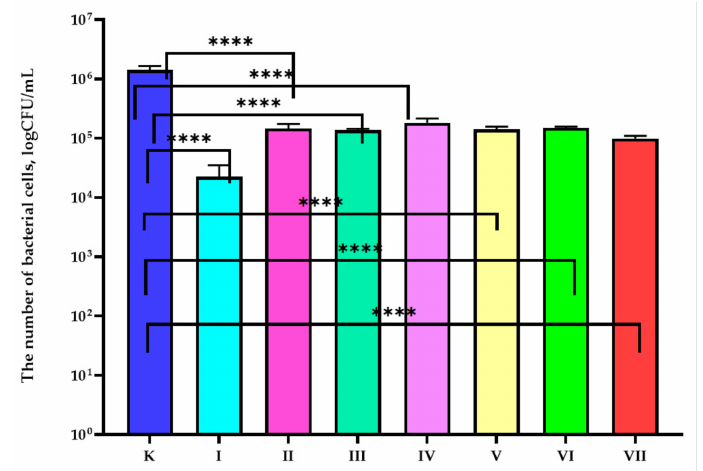
Figure 4. The influence of coated, active films on B . subtilis growth. One-way ANOVA test: ****— p < 0.0001.